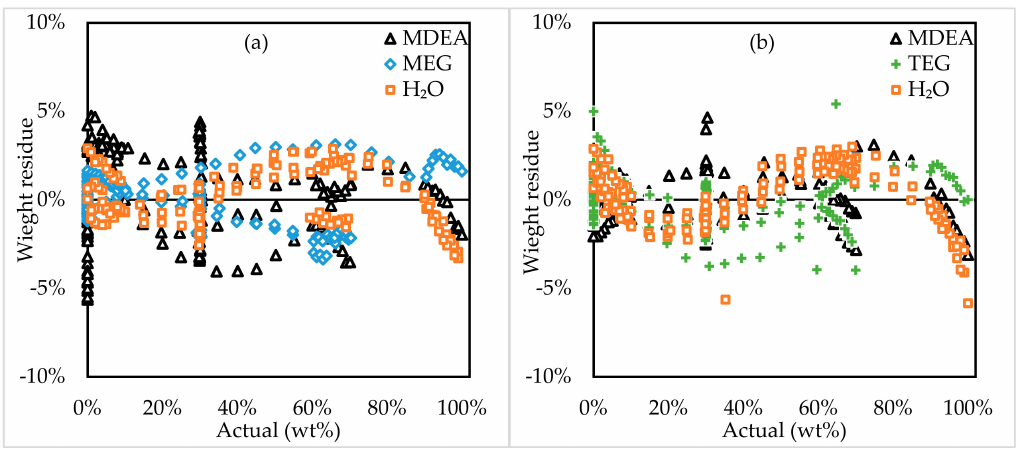
Figure 6. Weight residual of three-component systems; the MDEA-MEG-H 2 O system ( a ) and MDEA-TEG-H 2 O system ( b